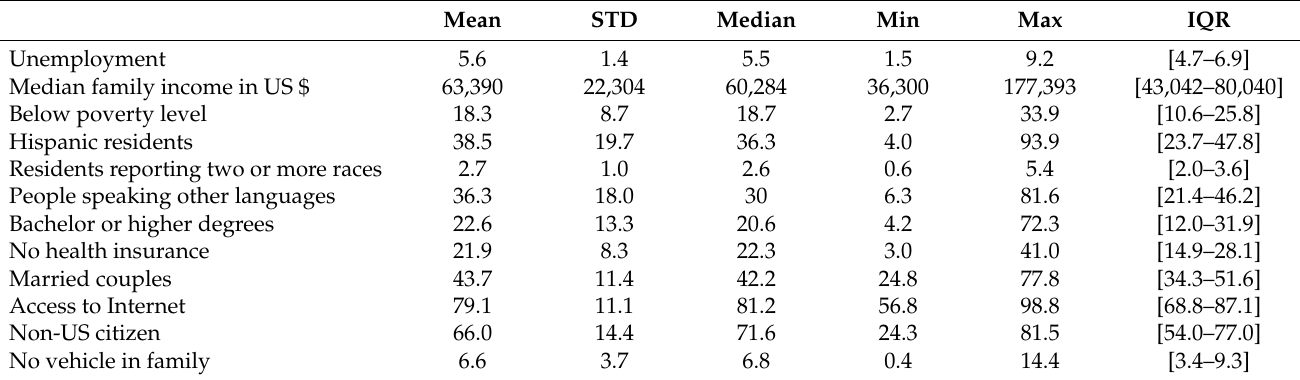
Table 2. Community-level social (DP02), economic (DP03), and demographics (DP05) characteristics percentages at the zip code-level, American Community Survey